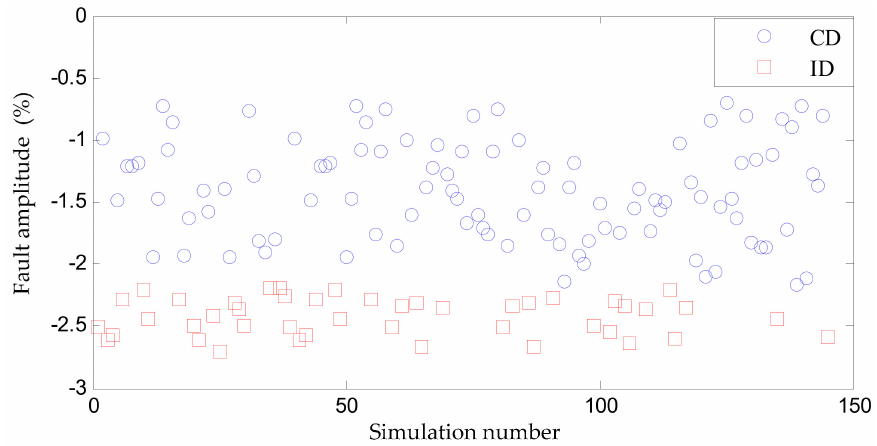
Figure 9. The fault amplitude of the F η pt fault and the corresponding FDI results of 145 simulations.